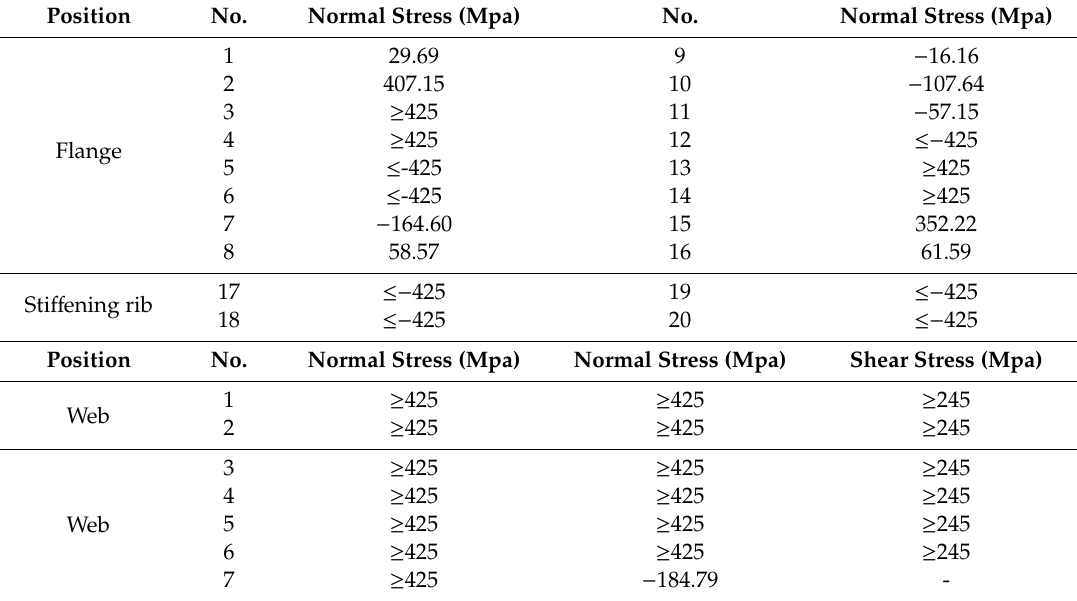
Table 5. The stress value of RSL-1 when D = − 72 mm (0.3274